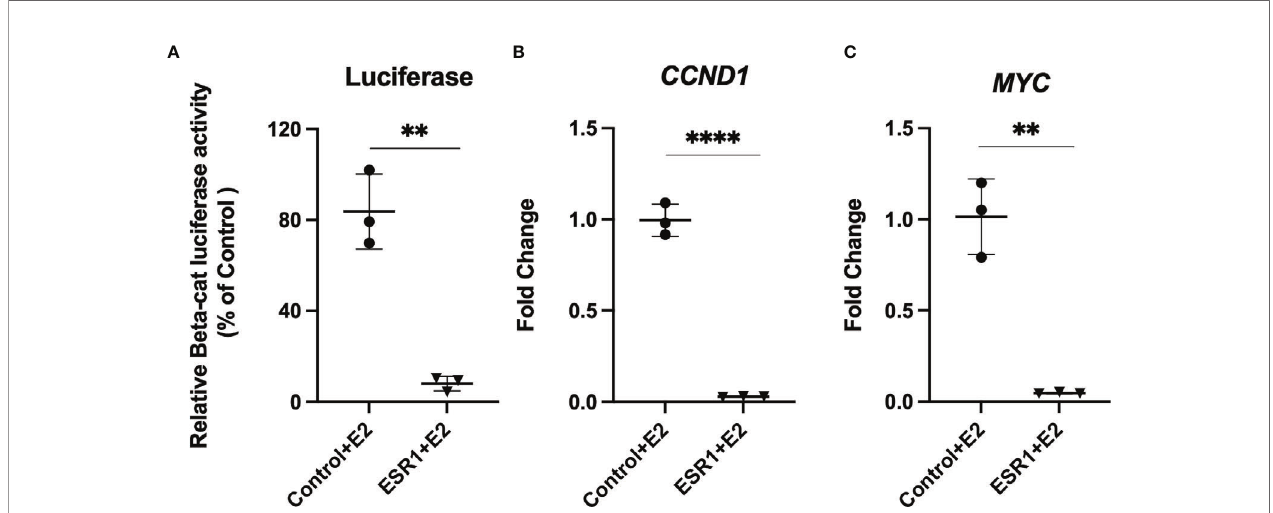
FIGURE 4 | ESR1 overexpression decreases transcriptional activity and gene expression of b -catenin and Wnt/ b -catenin signaling targets. (A) Representative bar graphs showing reduction of b -catenin transcriptional activity, as measured by luciferase assay in HepG2 cells following ESR1 co-transfection or control vector and exposure to E2 or vehicle. (B) Representative bar graphs showing reduction of mRNA expression of CCND1 in HepG2 cells as measured by Real-Time PCR. (C) Representative bar graphs showing reduction of mRNA expression of MYC in HepG2 cells as measured by Real-Time PCR. Mean with SD values from N = 3 independent experiments are represented in the graph. **p < 0.01, ****p < 0.0001 Student ’ s t-test. SD, standard deviation.